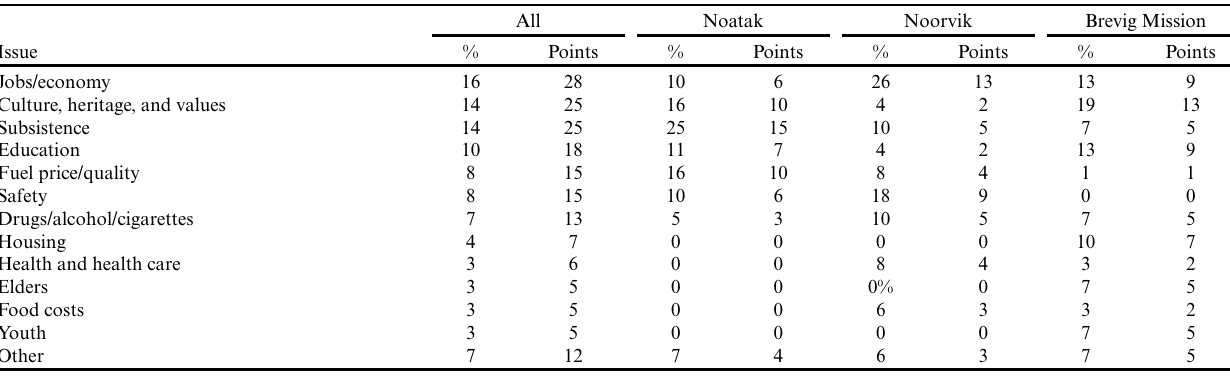
Table 2 . Important issues identified by interviewees among the communities. A tiered point system was used with first, second, and third mentions getting three, two, and one points, respectively. Issues counted under “other” include leadership, suicide prevention, technology, communication, and